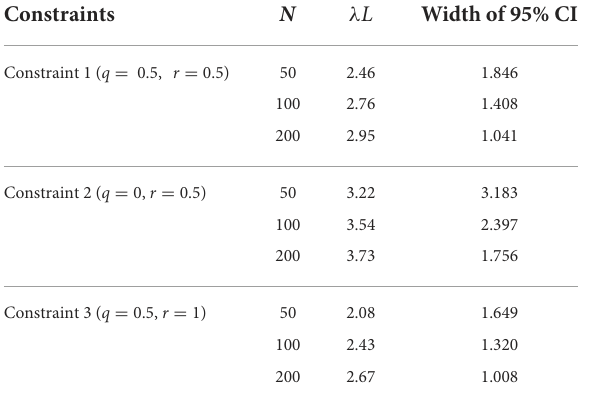
TABLE 5 The value of λ L and the width of 95% CI of estimated λ L when the optimum age parameter values are 0.5. Constraints N λ L Width of 95% CI Constraint 1 ( q = 0.5, r = 0.5) 50